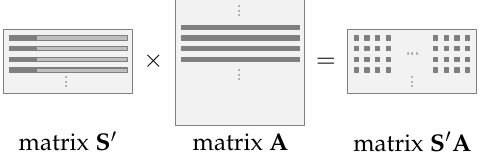
Figure 4. Operation S ′ A S ′ A . Multiplication of first four elements of the first four rows of the ← × matrix S ′ , highlighted in dark gray, by four rows of the matrix A .